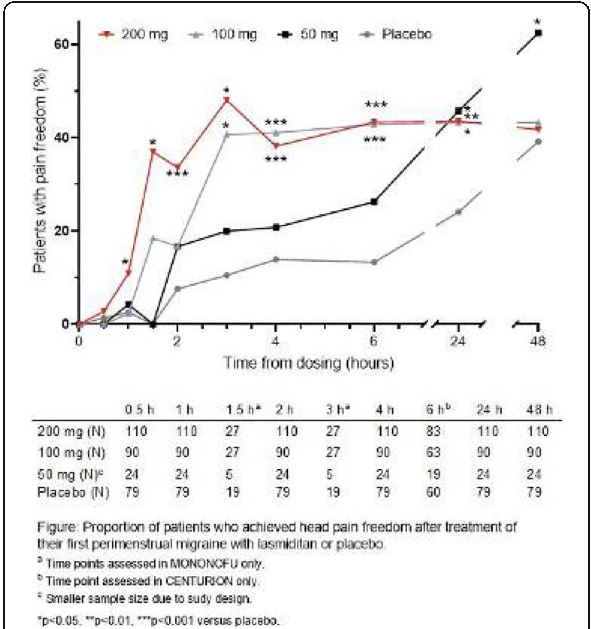
Fig. 1 (abstract P0265). See text for